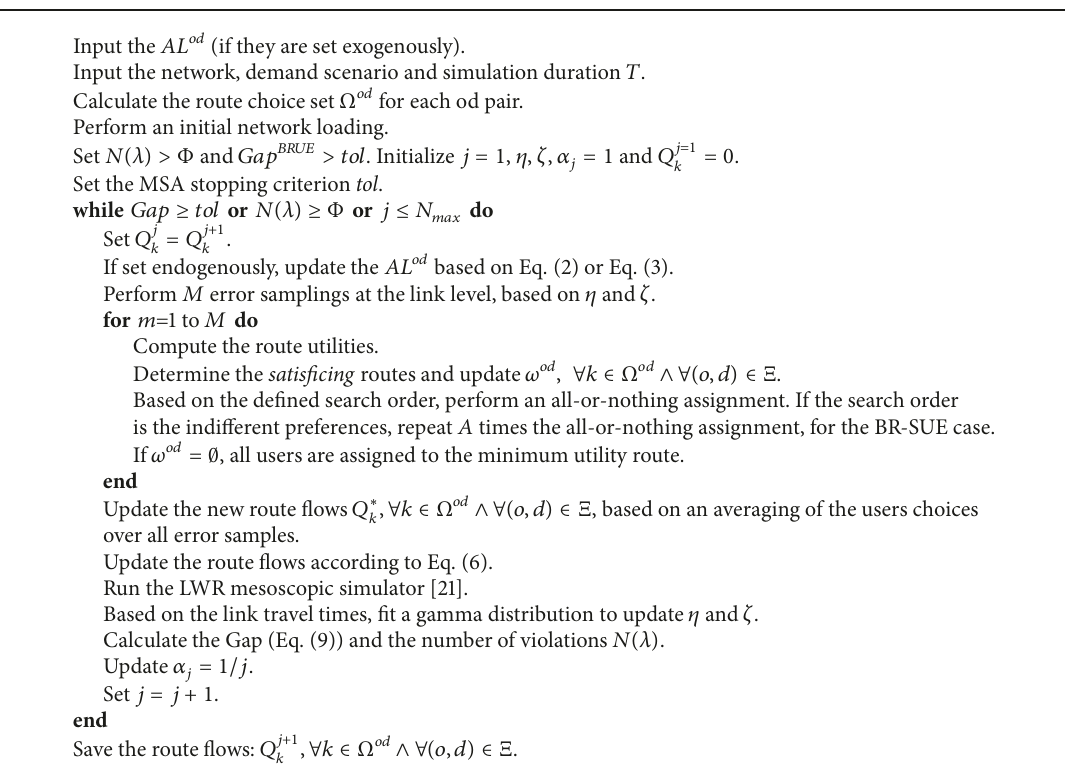
Algorithm 1: Dynamic implementation algorithm of the satisficing